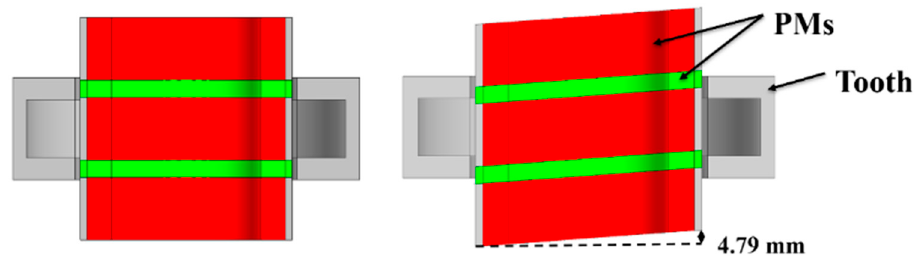
Figure 1. Cross-section of the 1 / 8 model without and with a skewing angle of 75 ◦ .